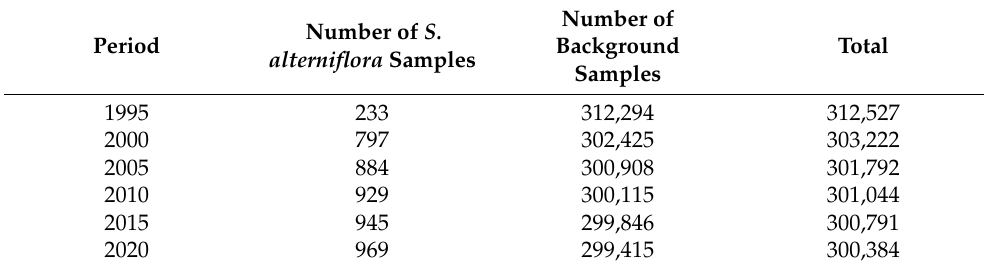
Table 3. Distribution of test samples from 1995 to 2020.